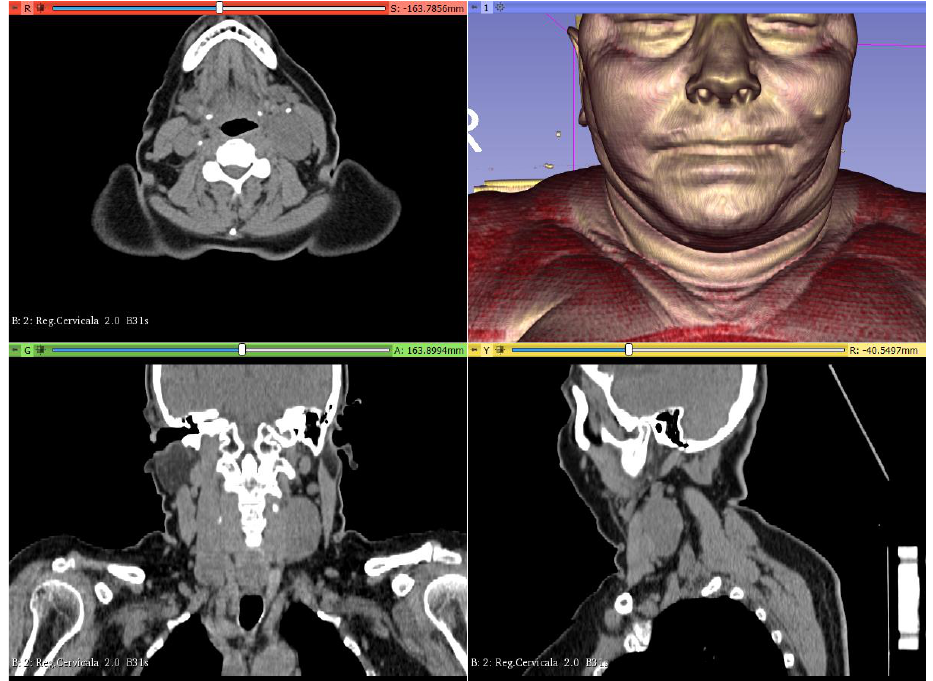
Figure 2. Axial view (red), coronal view (green), sagittal view (yellow), and 3D view (blue) of the head and neck computer tomography (CT) in 3D Slicer (www.3dslicer.org (accessed on 4 October 2021)) software. A well circumscribed cervical mass was observed in all sections. Asymmetric deformation of the left side of the neck was observed on the 3D view (blue).